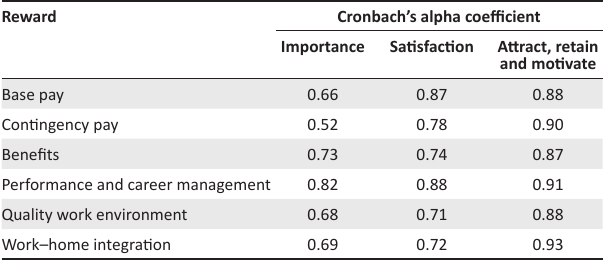
TABLE 2: Internal consistency statistics for reward categories’ summated